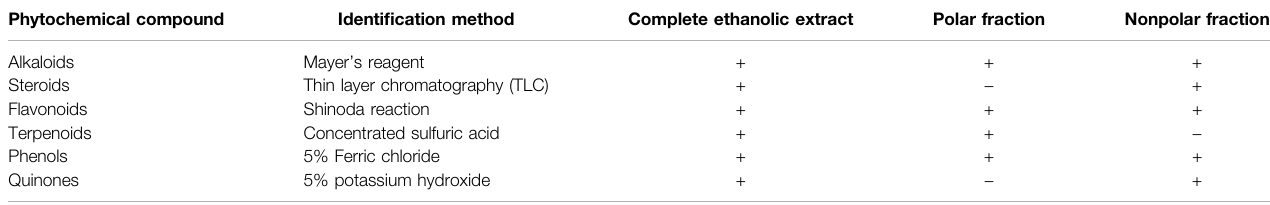
TABLE 2 | Phytochemical generic compounds present in the ethanolic extract and in polar and nonpolar fractions of Lophocereus schottii . Phytochemical compound